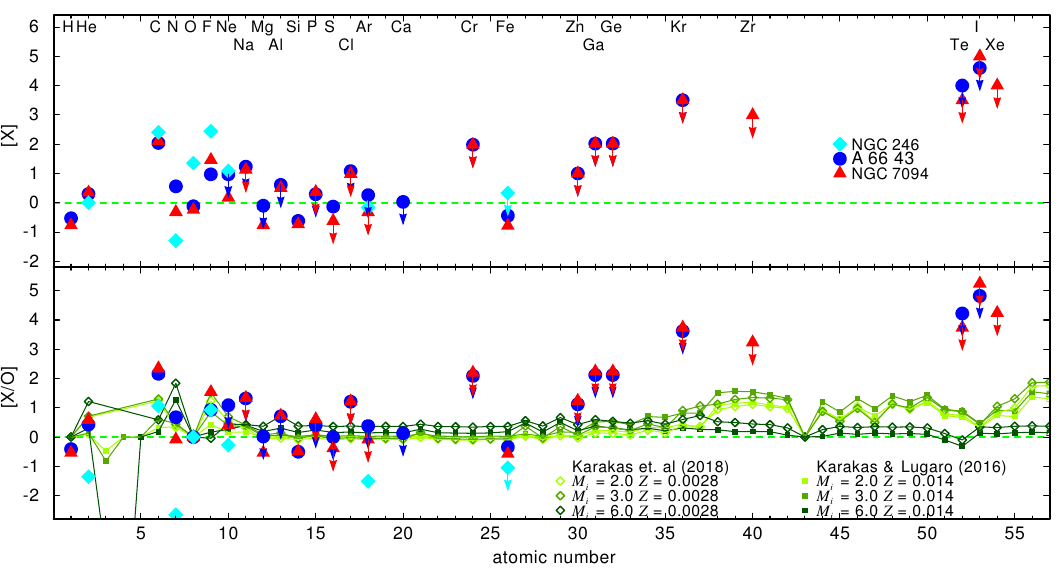
Figure 2. Photospheric abundances (estimated errors + / − 0.1 dex) of WD2134 − 125, WD1751 + 106, and WD 0044 − 121. Arrows indicate upper limits. In the lower panel, the abundances in [ X/O ] = log ( X/O ) − log ( X/O ) with the number fractions of element X and O are compared surf solar to the yields of the models from [17,18] for different initial masses.